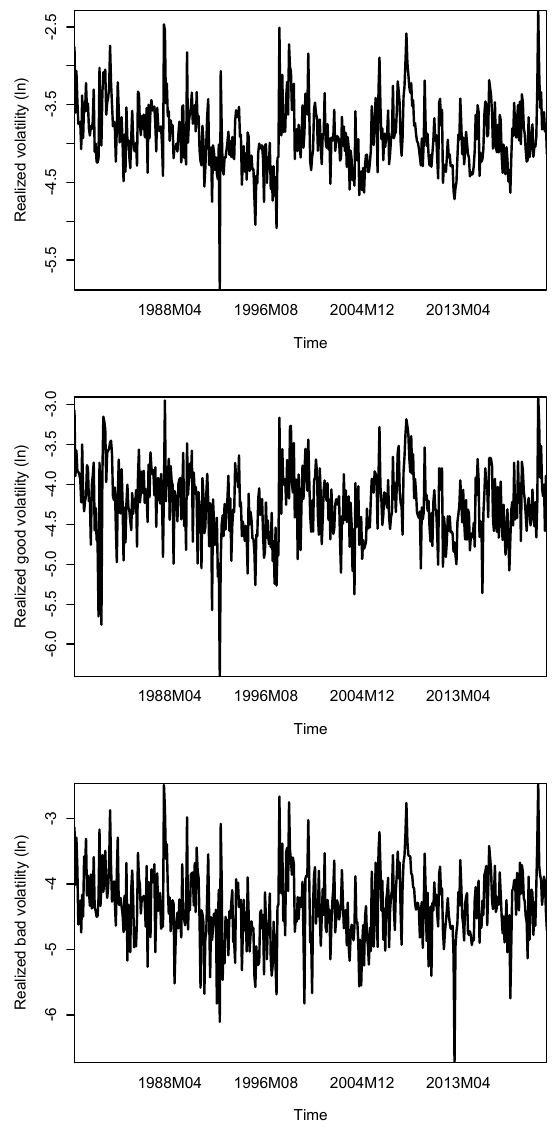
Figure 1. Realized